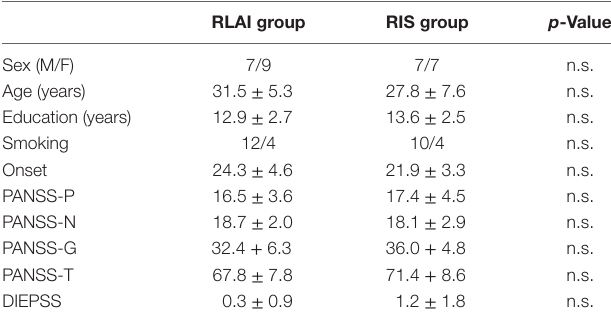
TaBle 1 | Demographic and clinical characteristics of the participants at baseline.